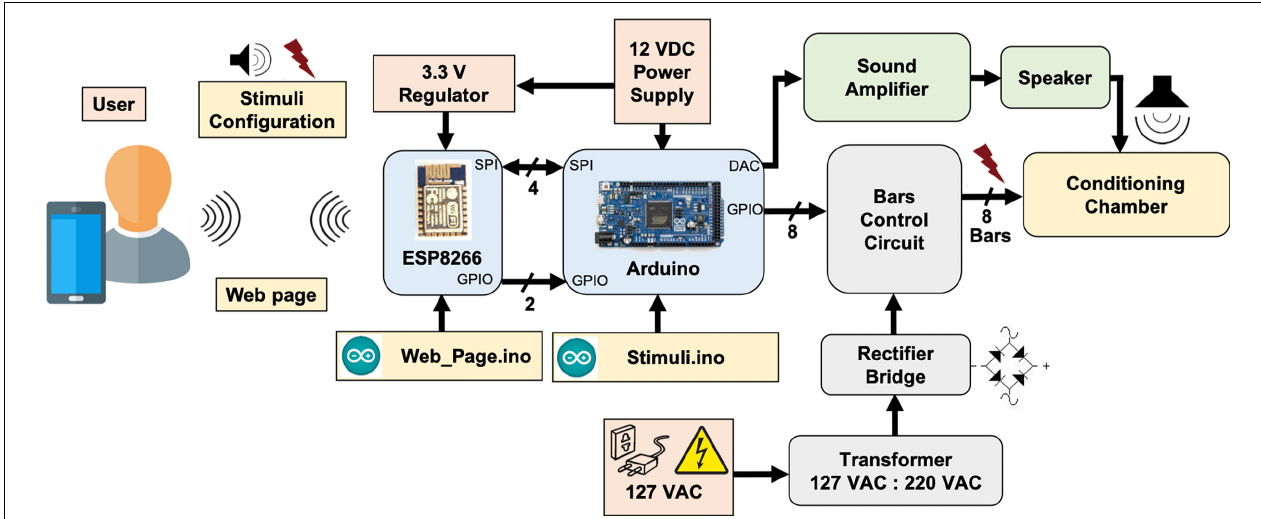
FIGURE 1 | System overview. ESP8266-12E module and Arduino Due board cooperates in order to generate custom modulating tones and aversive stimulation, based on footshocks applied through electrified bars, programed via user interface.